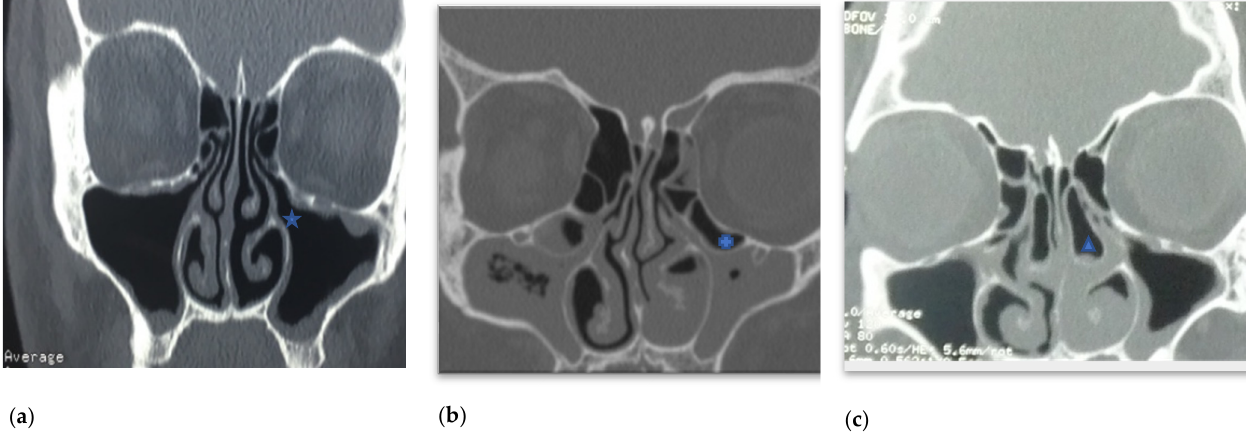
Figure 7. ( a ) Minor mucosal changes but patent OMC (star) ( b ) infraorbital cells blocking OMC (cross) ( c ) Concha Bullosa blocking OMC